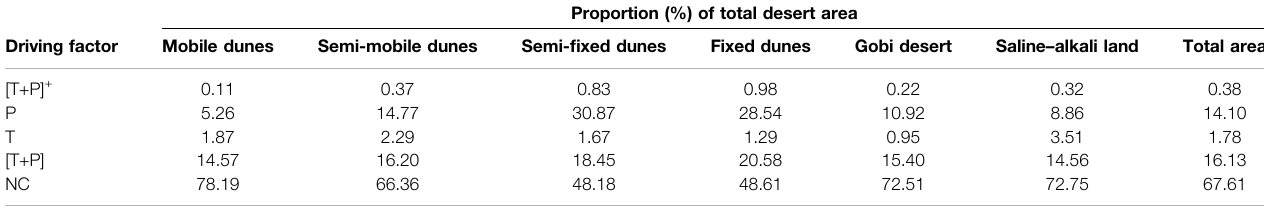
TABLE 3 | The proportion of the study area in which NDVI changes from 1998 to 2015 were dominated by different driving factors for the six desert